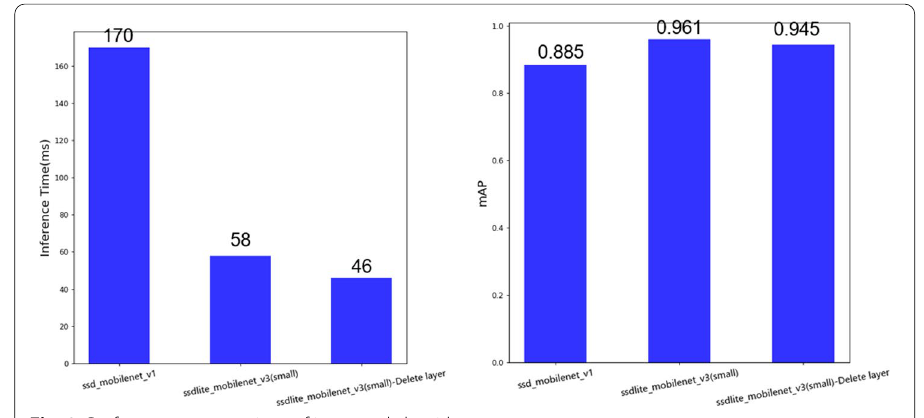
Fig. 8 Performance comparison of improved algorithms